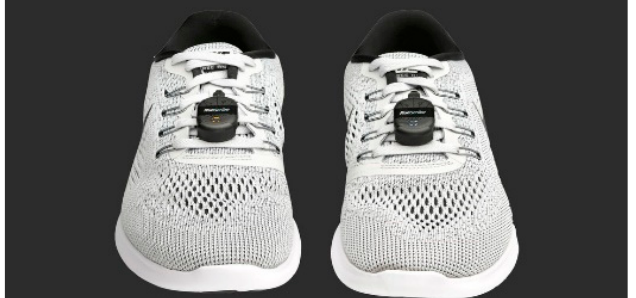
Figure 1. MEMS accelerometers placement.